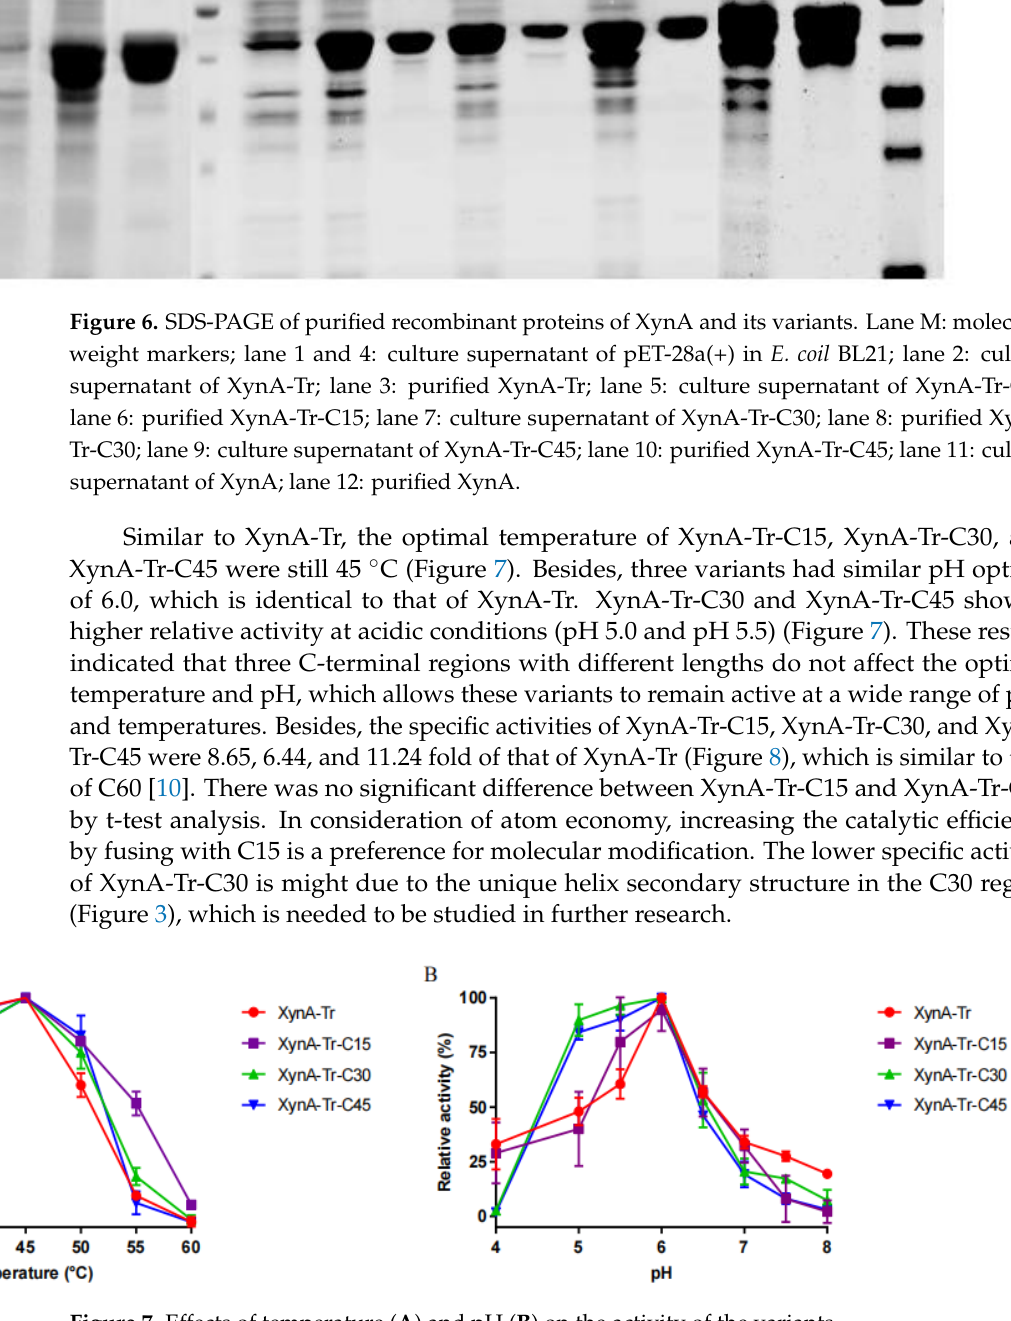
Figure 7. Effects of temperature ( A ) and pH ( B ) on the activity of the variants.